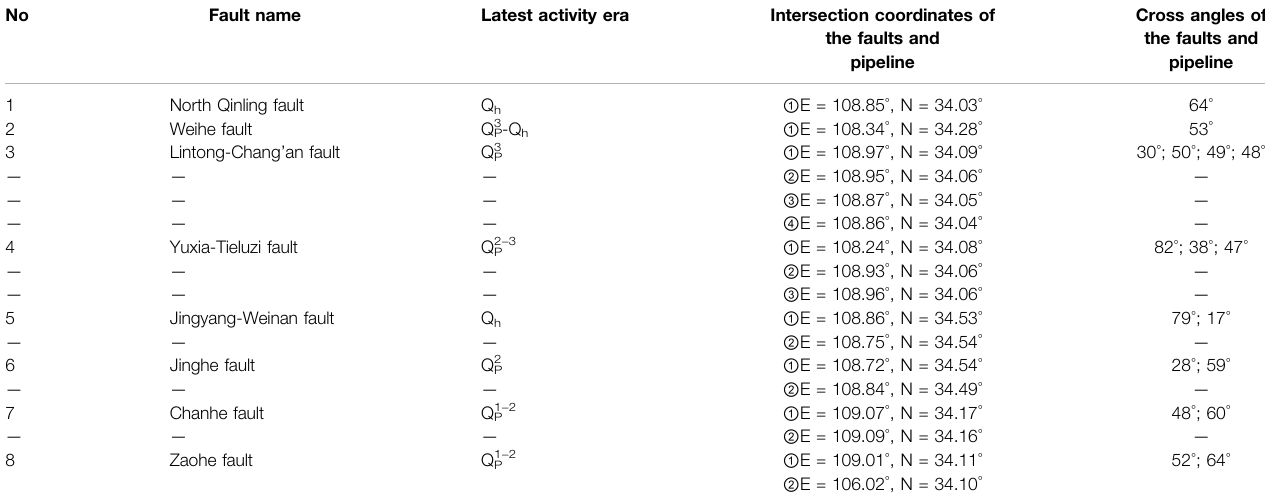
TABLE 1 | Intersection conditions of the faults and pipeline.